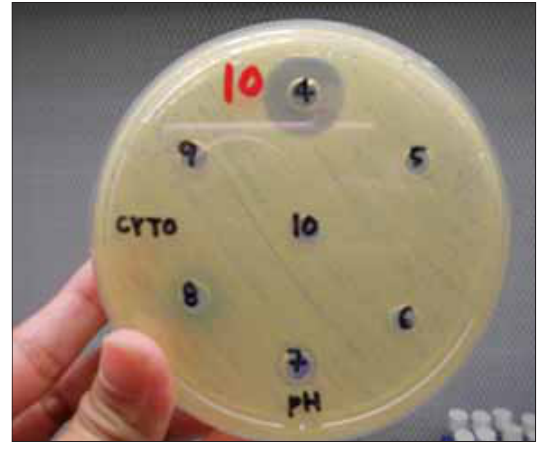
Figure-3: Clear inhibition zone of bacteriocin against Flavobacterium